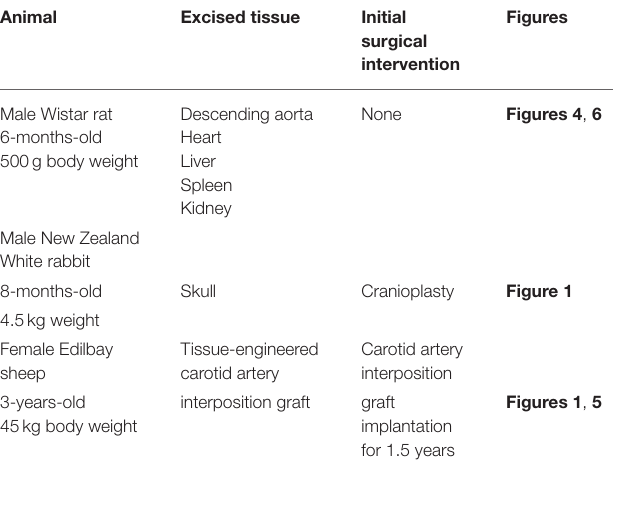
TABLE 3 | Clinical samples collected to exhibit the applicability of EM-BSEM in cardiovascular pathology. Clinical sample